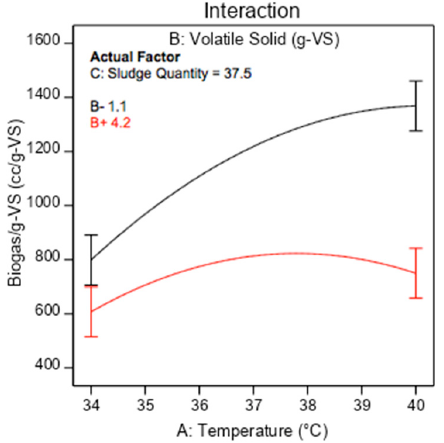
Figure 7. Interaction plot clarifies the effect of interaction between temperature and volatile solid on biogas g –1 -VS.